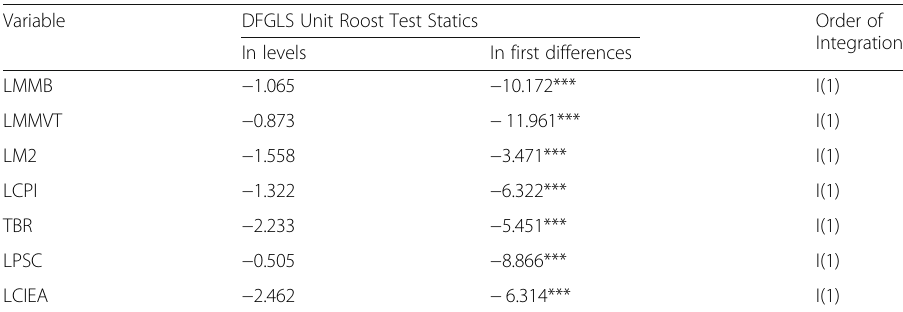
Table 3 Stationarity tests Variable DFGLS Unit Roost Test